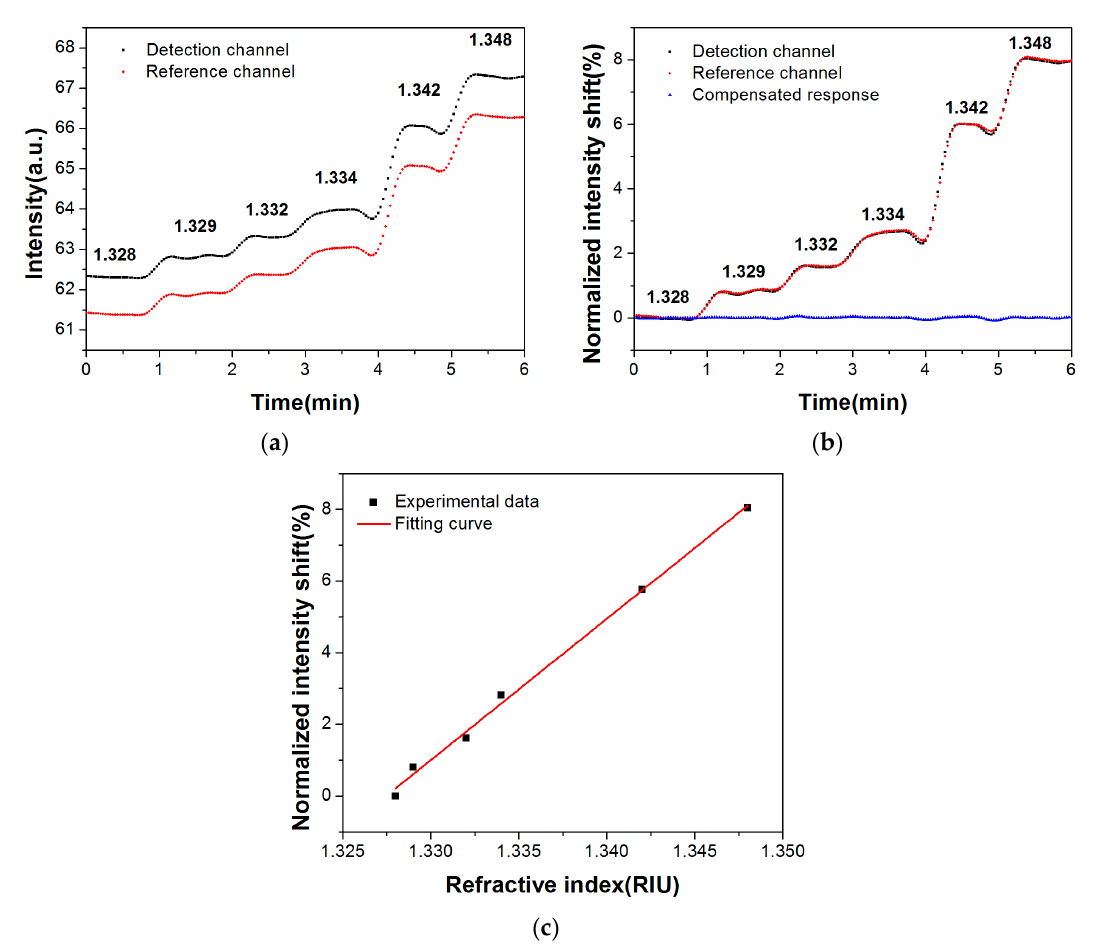
Figure 4. Real-time responses of the dual-channel SPR system upon sequential injection of sodium chloride solutions at increasing refractive index (1.328–1.348). ( a ) Original responses; ( b ) Normalized responses and compensated responses; ( c ) The fitting curve established by normalized intensity shift with different RIs.